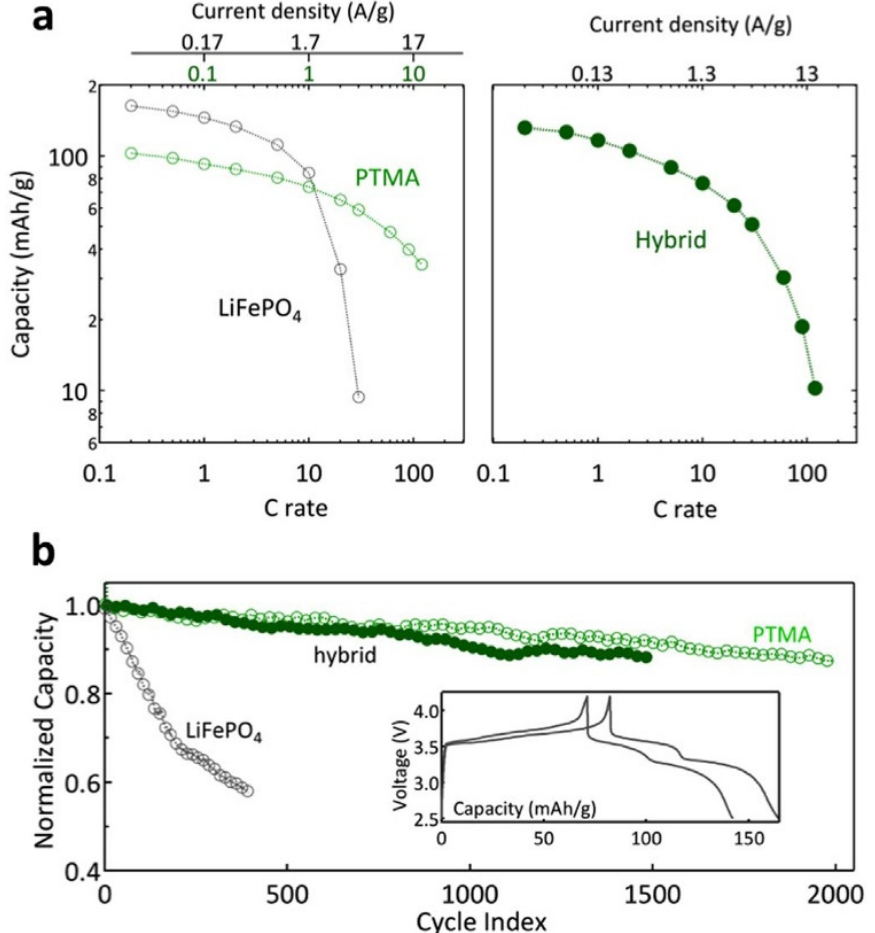
Figure 10. Electrochemical properties of the hybrid electrode. ( a ), Capacity retention function of C-rate and applied current density (symmetrical charge–discharge conditions) for LiFePO 4 , PTMA and hybrid electrode. The green and black top axes correspond to PTMA and LiFePO 4 , respectively. The rate of 1C corresponds to 100, 170 and 130 mAh/g for PTMA, LiFePO 4 and hybrid electrode, respectively. ( b ), Capacity retention at a charge–discharge rate of 5C for LiFePO 4 , PTMA and hybrid electrodes. Inset: voltage profiles for the hybrid electrode at 1st and 1000th cycle [107]. Reprint with permission from [107]; Copyright 2014, The Author(s).